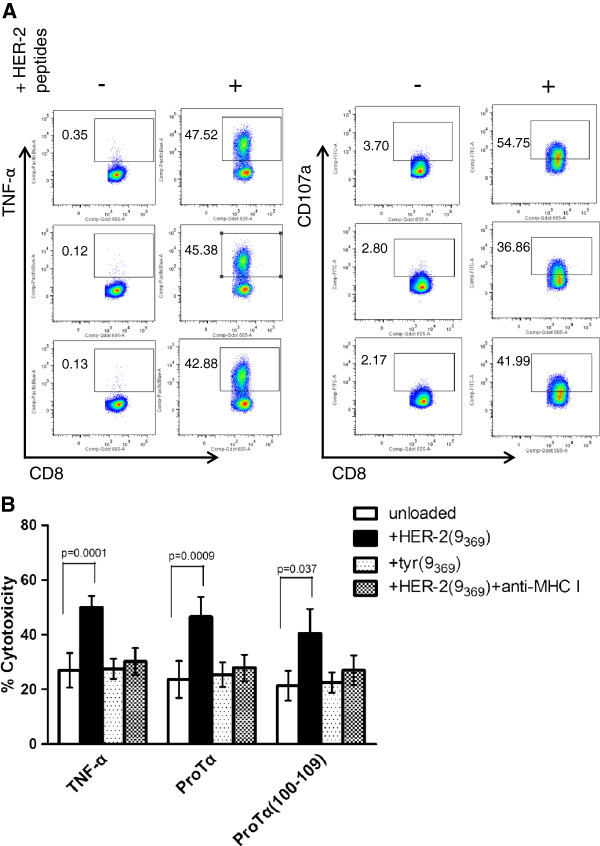
T cells stimulated with proTα- or proTα(100–109)-matured DCs are cytotoxic in the presence of HER-2(9369). (A) Intracellular production of TNF-α (left) and surface expression of CD107a (right) in CD8+ T cells stimulated with DCs matured for 48 h with TNF-α (first row), proTα (middle row) or proTα(100–109) (bottom row), in the absence (−) or presence (+) of the HER-2/neu peptides. Numbers indicate percentages of positive cells on gated CD8+ T cells. Shown are data from one representative experiment of 5 performed. (B) T cells stimulated with TNF-α-, proTα- or proTα(100–109)-matured DCs, were used as effectors (E) against unloaded, HER-2(9369)- and tyr(9369)-loaded T2 targets (T). Where indicated, mAb to MHC class I molecules was added throughout the culture period at a final concentration of 5 μg/mL. In all assays the E:T ratio was 10:1. Data represent mean % cytotoxicity ± SD from 2–5 donors.